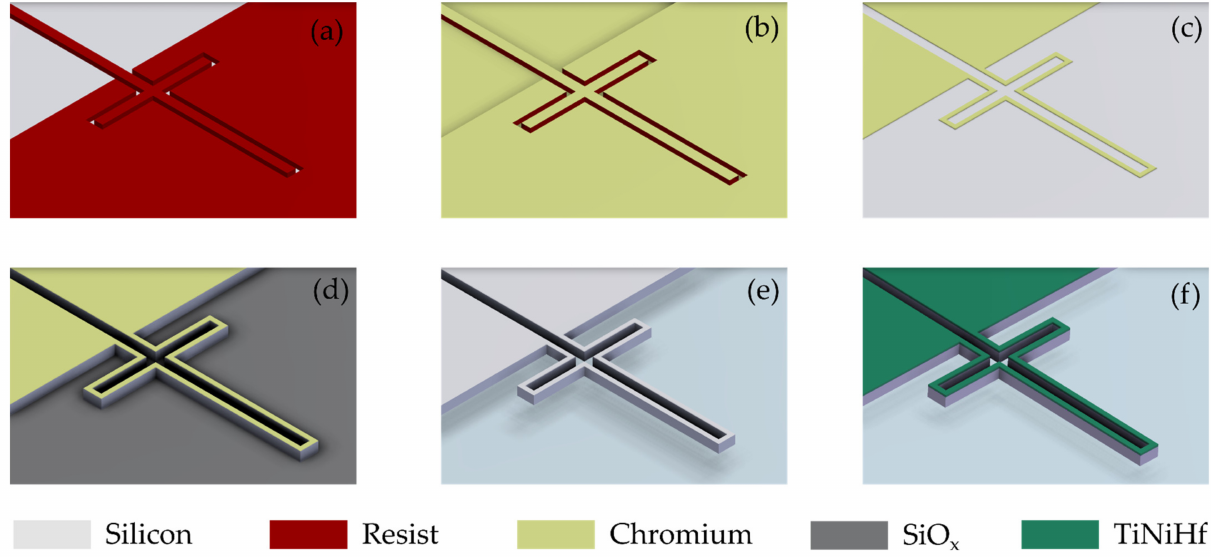
Figure 3. Schematic process flow for fabrication of TiNiHf /Si microactuators using an SOI wafer with 2 µ m Si device layer, ( a ) patterning of resist using EBL, ( b ) chromium deposition, ( c ) lift-off of chromium, ( d ) RIE of Si using cryogenic etching, ( e ) stripping of chromium and selective etching of SiOx sacrificial layer and ( f ) sputtering and annealing of TiNiHf thin